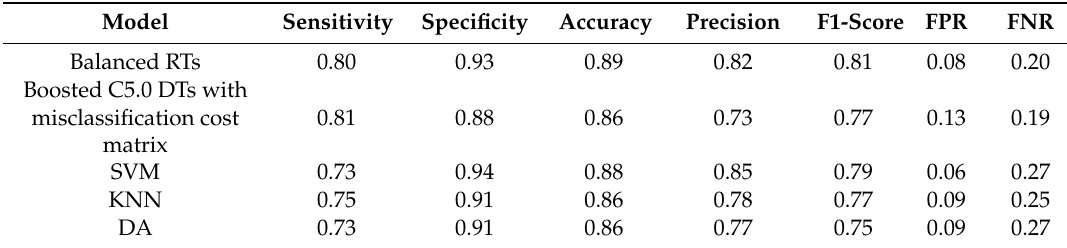
Table 6. Statistical results of individual classification models on the test subset of 888 substances (263 RB and 625